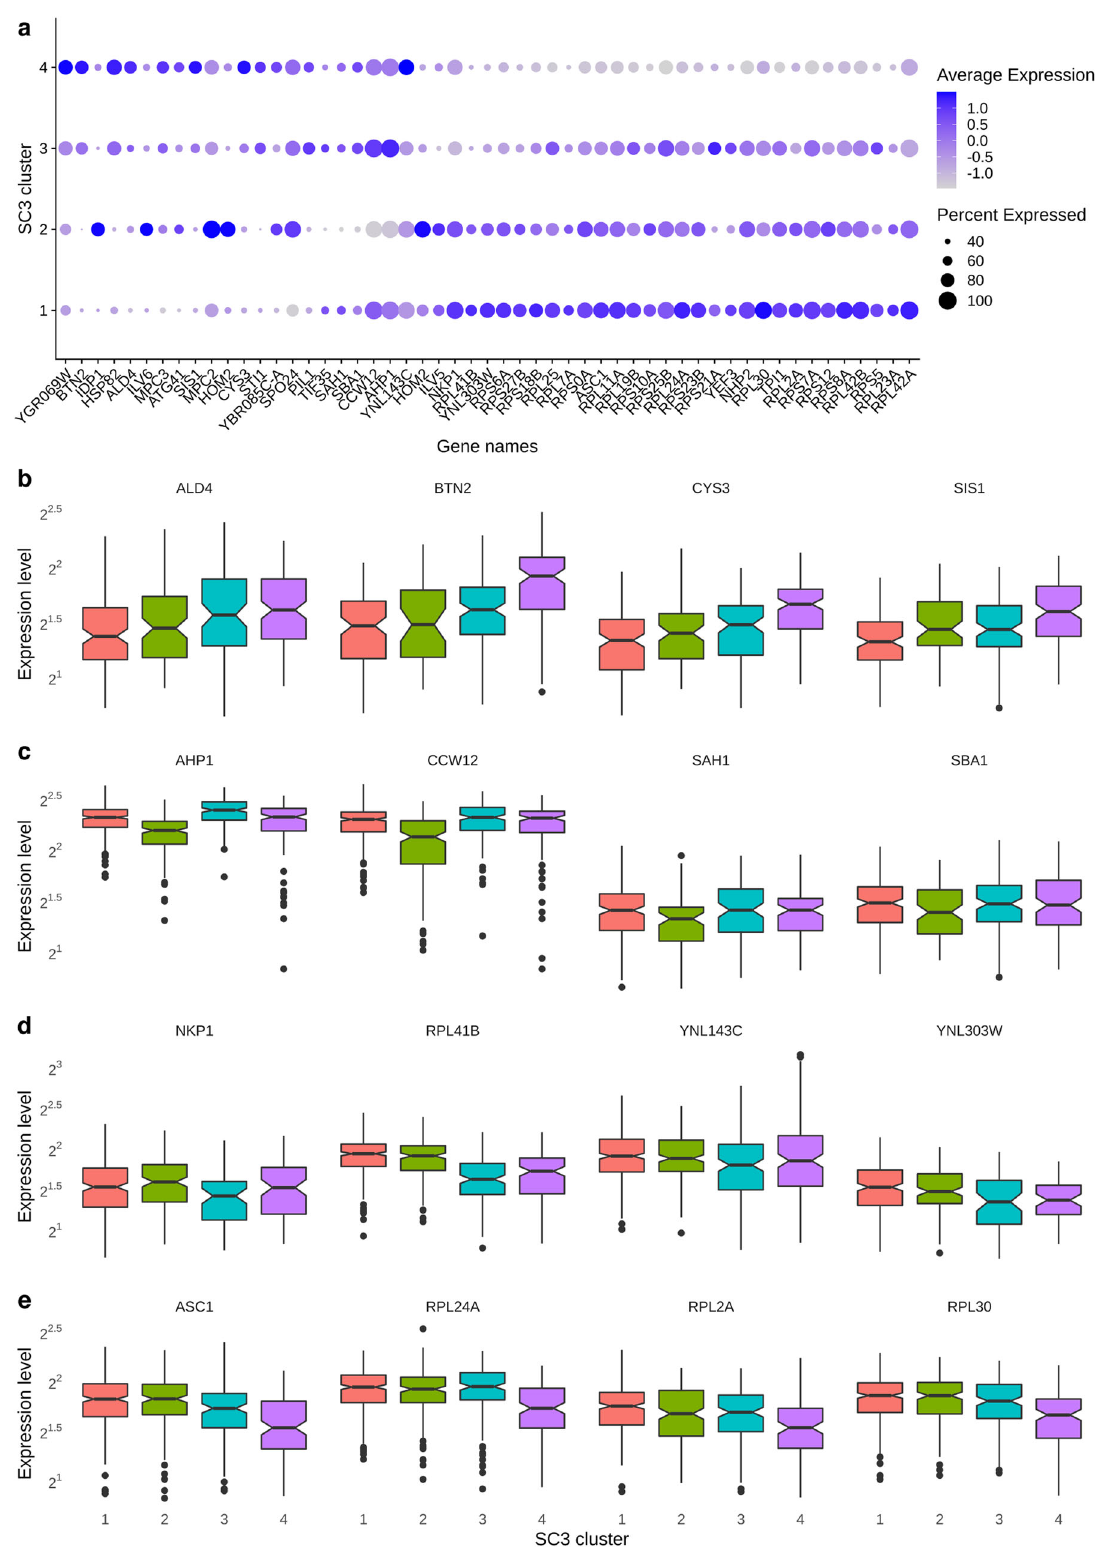
Fig. 5 DE genes in the SC3 clusters with k = 4. a Dotplot showing the key DE genes (Methods) identi fi ed in the 4 SC3 clusters. The size of the dot represents the percentage of cells within a SC3 cluster expressing the corresponding genes, while the color represents the average expression level in natural-log scale of the corresponding genes across all cells within a sample (blue is high). b Boxplot showing the top 4 DE genes in SC3 cluster 1. c Boxplot showing the top 4 DE genes in SC3 cluster 2. d Boxplot showing the top 4 DE genes in SC3 cluster 3. e Boxplot showing the top 4 DE genes in SC3 cluster 4. Boxplots show the median (center line), interquartile range (hinges) and 1.5 times the interquartile range (whiskers); outlier data beyond this range are plotted as individual points. Expression levels are plotted in log 2 scale of normalized UMI (Methods). DE genes means differentially expressed genes. (cluster 1 n = 331, cluster 2 n = 193, cluster 3 n = 164, cluster 4 n = 156